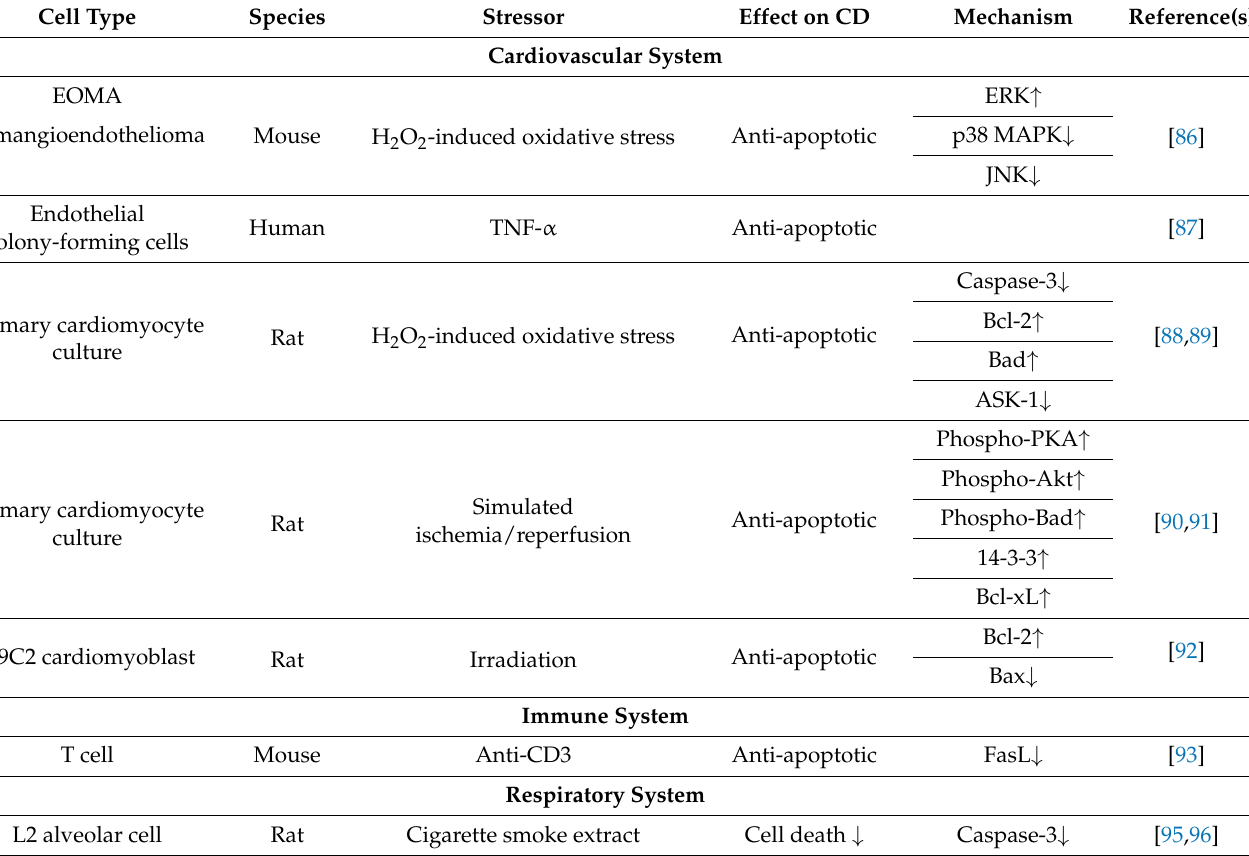
Table 3. Effects of exogenous and endogenous PACAP in vitro on cell death (CD) in the peripheral organs. If type of cell death was not specified in the cited study, the term “cell death” was used. * shows effects of endogenous